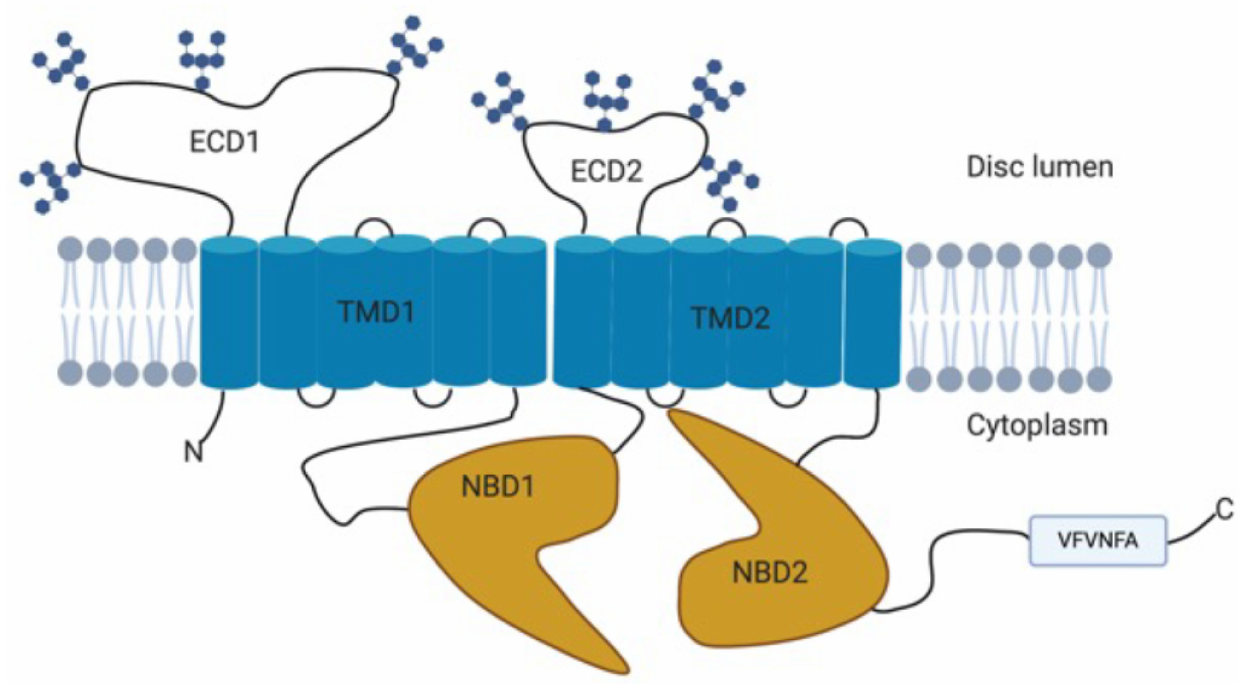
Figure 2. Schematic diagram of the structure of the ABCA4 protein showing the two transmembrane domains (TMD), the nucleotide-binding domains (NBD), and exocytoplasmic domains (ECD) that contain N-linked oligosaccharide chains and the C-terminal VFVNFA motif. Adapted from [33,37,38]. Created with BioRender.com (accessed on 1 June